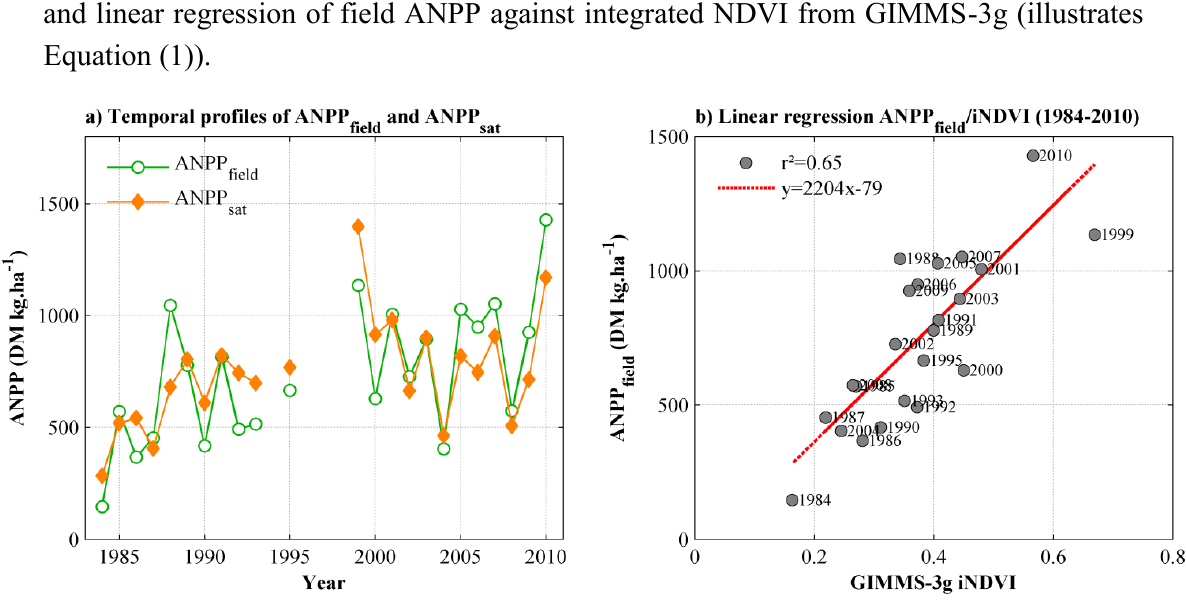
Figure 4. ( a ) Regression of field ANPP against JJASO rainfall. ( b ) Same for satellite-derived ANPP. The year is indicated next to each point